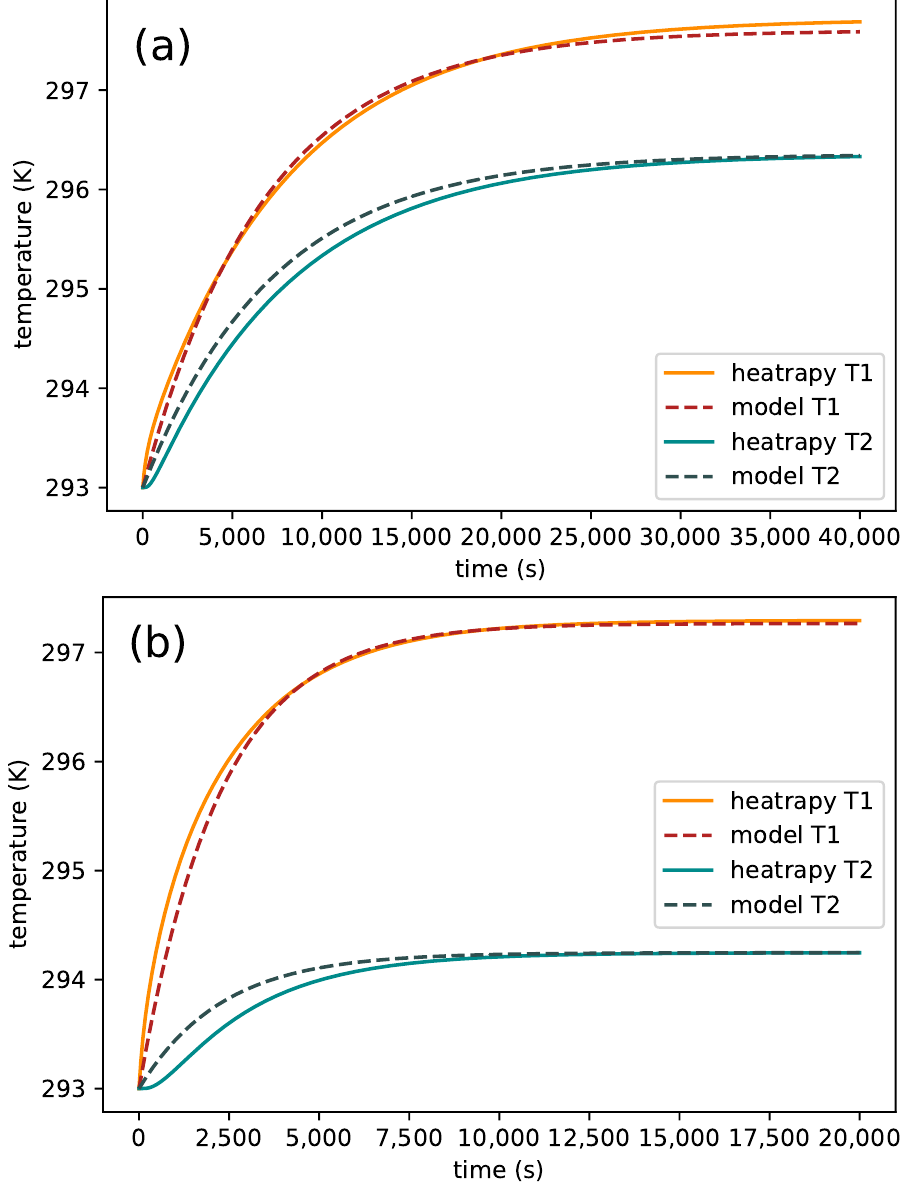
Figure 4. Temperature evolution using the developed model and the heatrapy simulations for thermal circuits with ( a ) two thermal resistance in series ( b ) and an alternate case. The used thermal resistances were made of Cu and Si solid